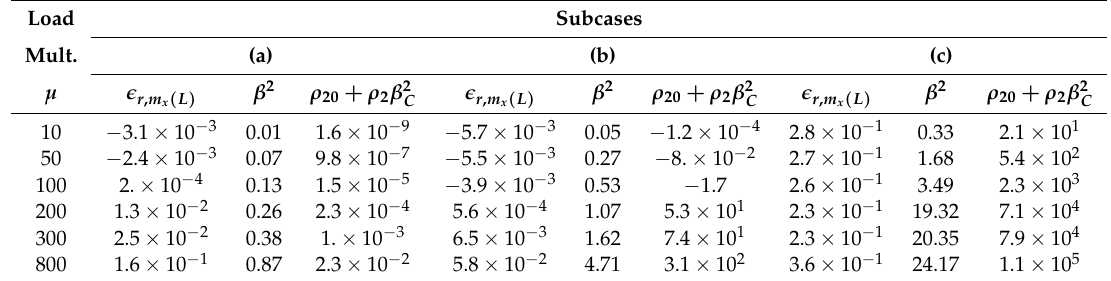
, Searle parameter β 2 = x ( L )